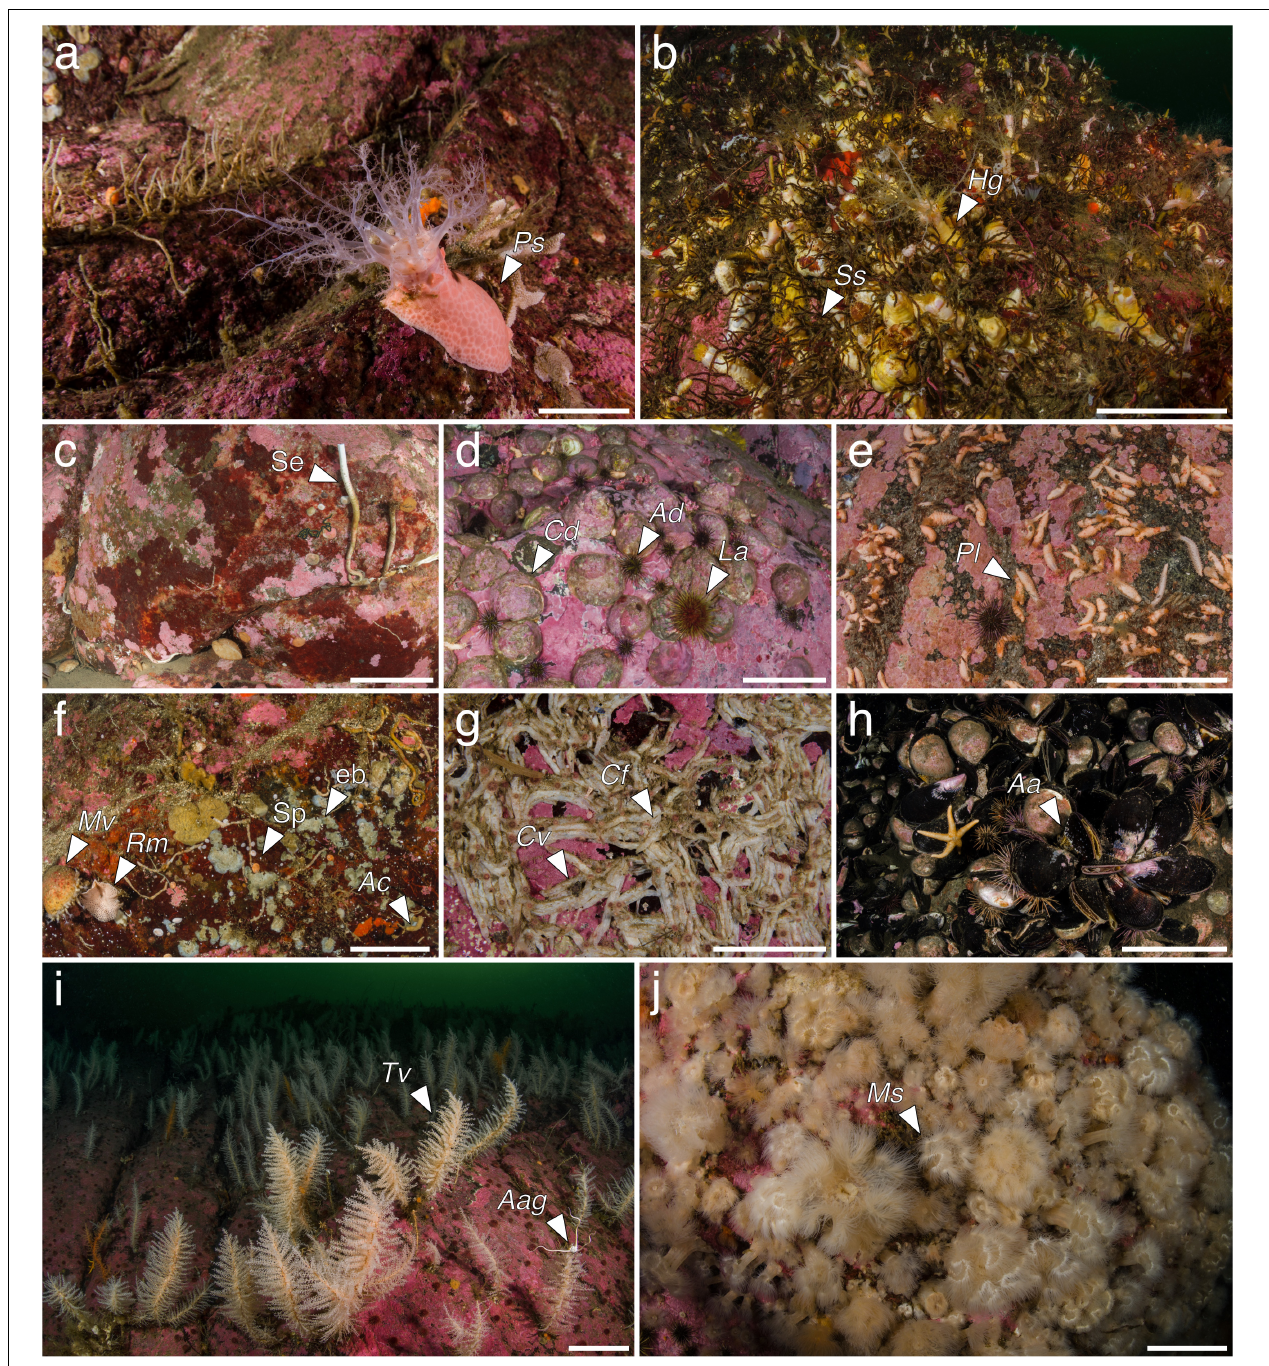
FIGURE 5 | Megabenthic communities identified along the Puyuhuapi–Jacaf fiord system. Psolus sp. ( Ps ) aggregations (a) ; Spiochaetopterus sp. ( Ss ) and Heterocucumis godeffroyi ( Hg ) gardens (b) ; Serpulidae (Se) aggregations (c) ; Loxechinus albus ( La ) aggregations (d) including Arbacia dufresnii ( Ad ) and Crepipatella dilatata ( Cd ); Pentactella leonina ( Pl ) aggregations (e) ; community of deep walls and crevices (f) including Spirorbinae (Sp), encrusting bryozoans (eb), Axinella crinita ( Ac ), Reteporella magellensis ( Rm ), and Magellania venosa ( Mv ); Chaetopterus variopedatus ( Cv ) aggregations (g) including Clathrina fjordica ( Cf ); Aulacomya atra ( Aa ) belt (h) , deep gorgonian forests (i) including Thouarella cfr. variabilis ( Tv ) and Astrotoma agassizii ( Aag ); Metridium cfr. senile ( Ms ) gardens (j) . Scale bars: (a) 2 cm; (b–i) 10 cm; (j) 5 cm.